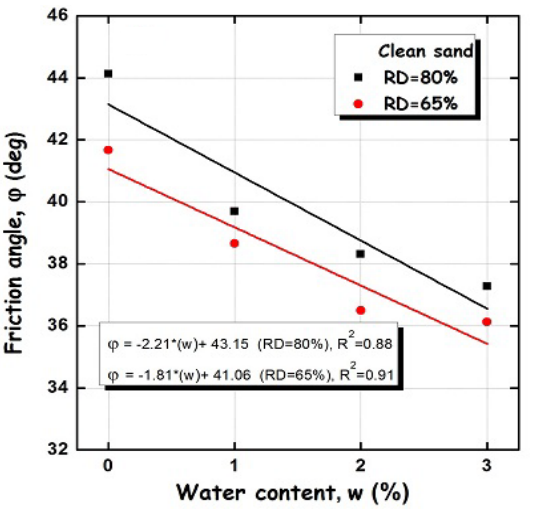
Figure 15: Effect of water content on the friction angle versus water content of clean sand.